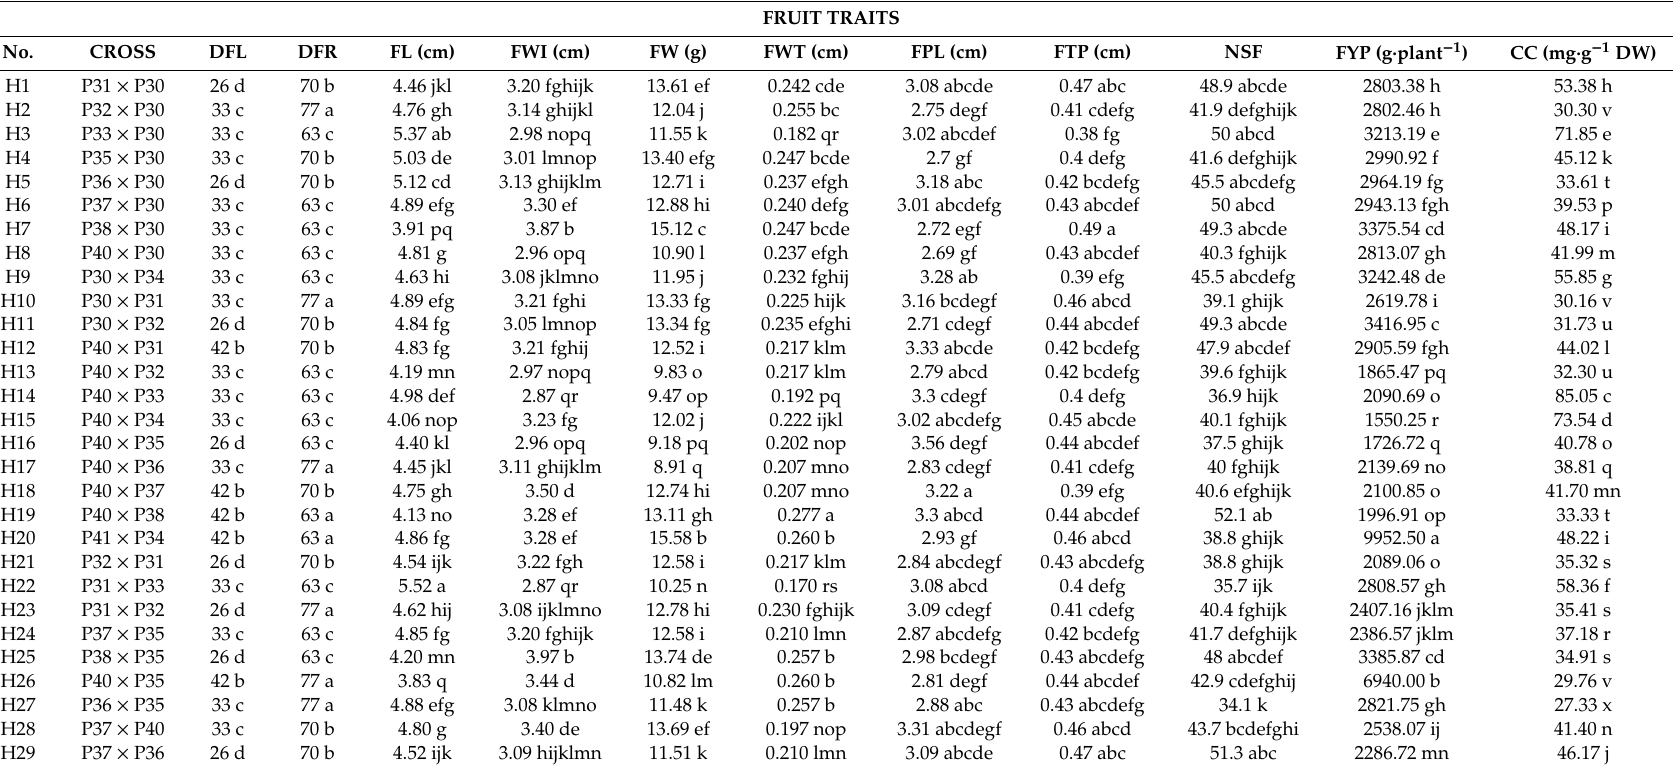
Table 6. Variation in the quantitative traits evaluated in F1 lines and progenitors of habanero pepper. FRUIT